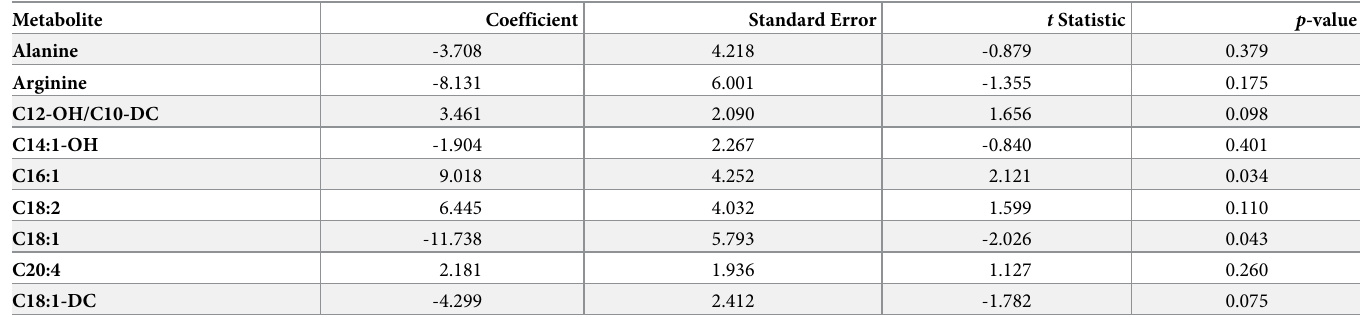
Table 2. Multivariable regularized linear model